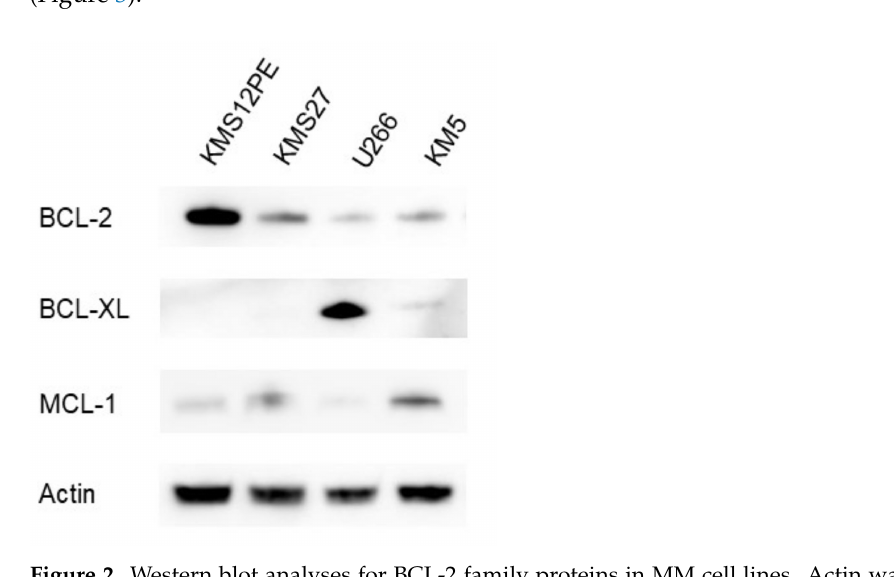
Figure 2. Western blot analyses for BCL-2 family proteins in MM cell lines. Actin was used as a loading